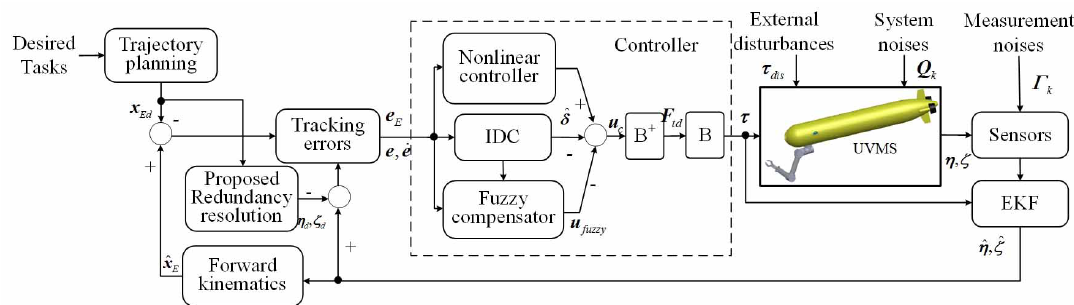
Figure 4. Block diagram of the proposed